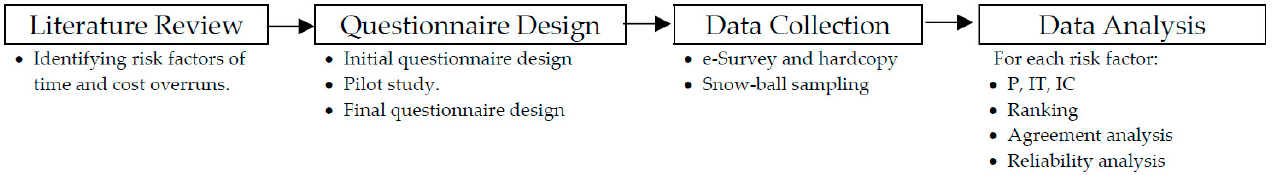
Figure 1. Research methodology process.